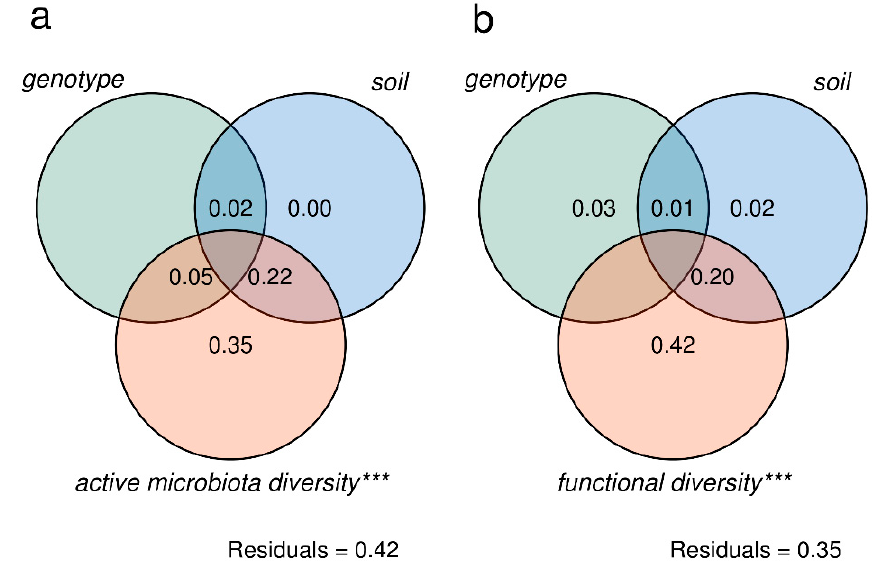
Figure 5. Variance partitioning analysis on meta-transcriptome and plant transcriptome profiling. ( a ) Tomato transcriptome variance explained by genotype, soil, and active microbiota diversity (bacteria and fungi). ( b ) Tomato transcriptome variance explained by genotype, soil, and mapped COG terms (functional diversity). Residuals, unexplained variance fractions (discrepancy between the data and an estimation model). Significant fractions are indicated by asterisks (ANOVA on RDA model, * p < 0.05; ** p < 0.01; *** p < 0.001).